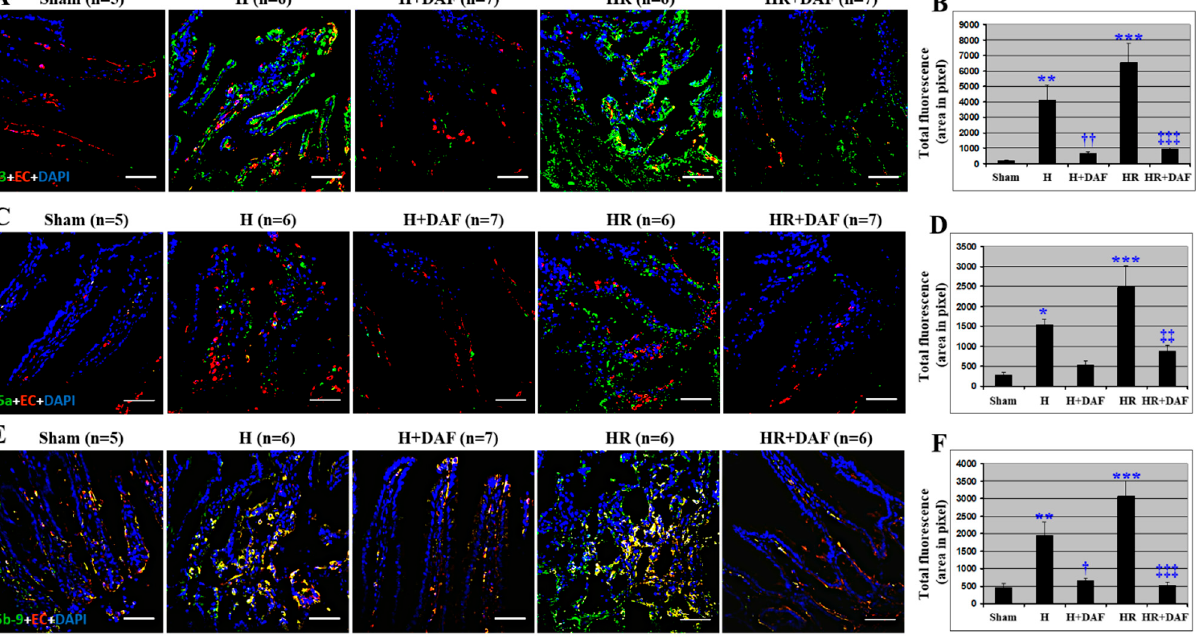
Figure 7. DAF inhibits deposition/generation of C3, C5a, and C5b ‒ 9 in the small intestine in rats subjected to hemorrhagic shock. C3 deposition ( A ), C5a generation ( C ), and C5b ‒ 9 formation ( E ) on intestinal endothelium were determined by histochemistry using anti ‒ C3, anti ‒ C5a, anti ‒ C5b ‒ 9, and anti ‒ endothelial cell antibodies. Quantitative data of C3 ( B ), C5a ( D ), and C5b ‒ 9 ( F ) fluorescent signals of the intestinal tissues were measured by Photoshop and ImageJ software as stated in Materials and Methods. Original magnification × 400. Scale bar = 50 μ m. * p < 0.05, ** p < 0.01, and *** p < 0.001 vs. sham; † p < 0.05, and †† p < 0.01 vs. H; ‡‡ p < 0.01, and ‡‡‡ p < 0.001 vs. HR (one ‒ way ANOVA followed by Tukey’s test).